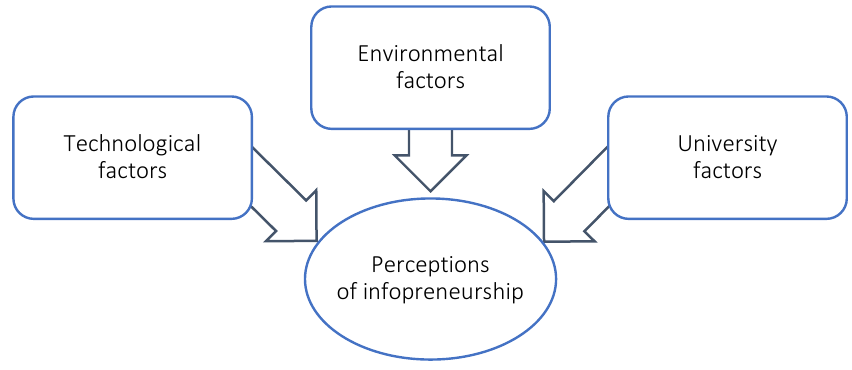
Perceptions Figure 1. Conceptual framework